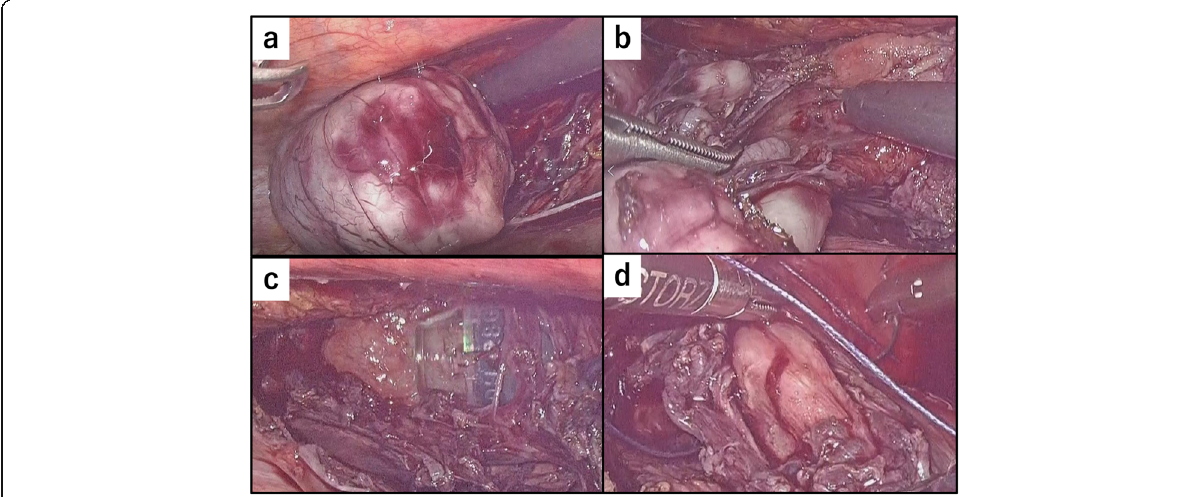
Fig. 5 Thoracoscopic surgical procedure. a Cutting the outer membrane of the esophagus around the tumor then dissecting the muscular layer in the esophageal wall along the cut edge of the outer membrane. b Connecting the enucleation layer to the submucosal tunnel created during the endoscopic procedure. c View after enucleating the tumor with the endoscope passed through the submucosal tunnel. d Closing the defect in the muscularis using continuous